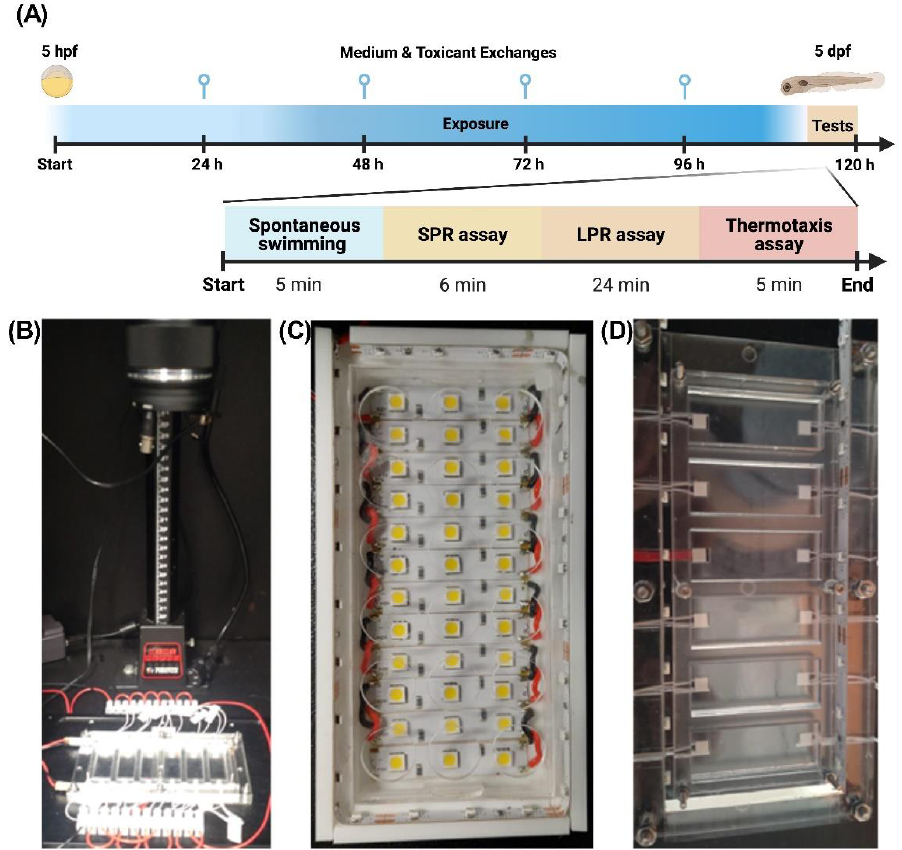
Figure 2. A high throughput multidimensional behavioral test battery ( A ) workflow depicting protocol of the multidimensional behavioral test battery. Zebrafish were exposed to toxicants in the embryonic stage (5 hpf) through to free swimming larval stage (5 dpf), with media exchanges occurring daily. The larval zebrafish then underwent the automated battery comprised of the spontaneous swimming (SS), simulated predator response (SPR), larval photomotor response (LPR) assays as well as a new thermotaxis (TX) biotests; ( B ) Overview of the purpose build analytical system used in the multidimensional behavioral test battery; ( C ) A photic module used for SPR and LPR stimuli biotests, ( D ) An electrothermal module used for thermotactic